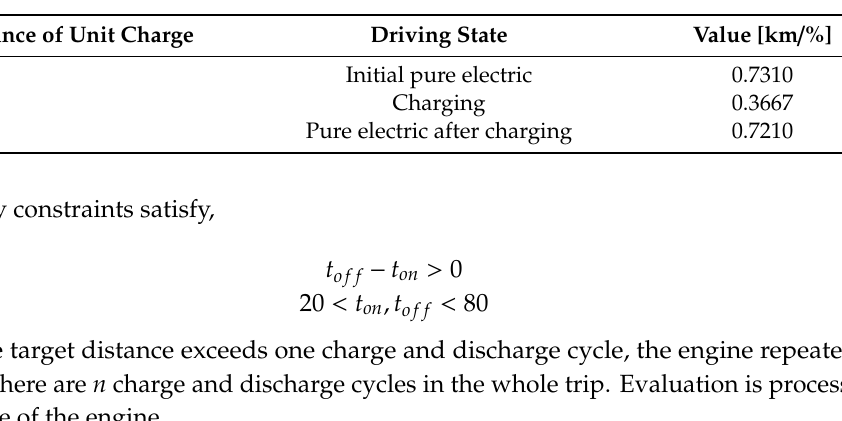
Table 2. Driving distance per unit